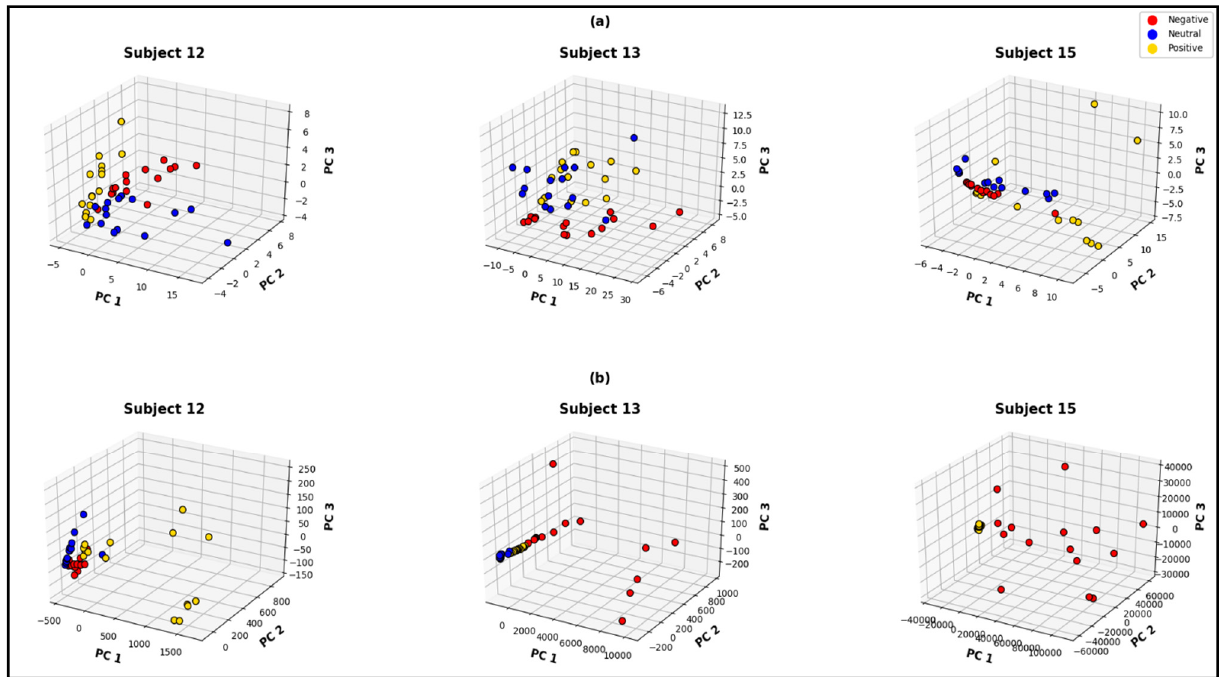
Figure 12. Three-dimensional principal-component visualization of ( a ) the computed MUSIC feature space and ( b ) non-parametric (Welch) feature space after excluding the corrupt channels before channel reduction.